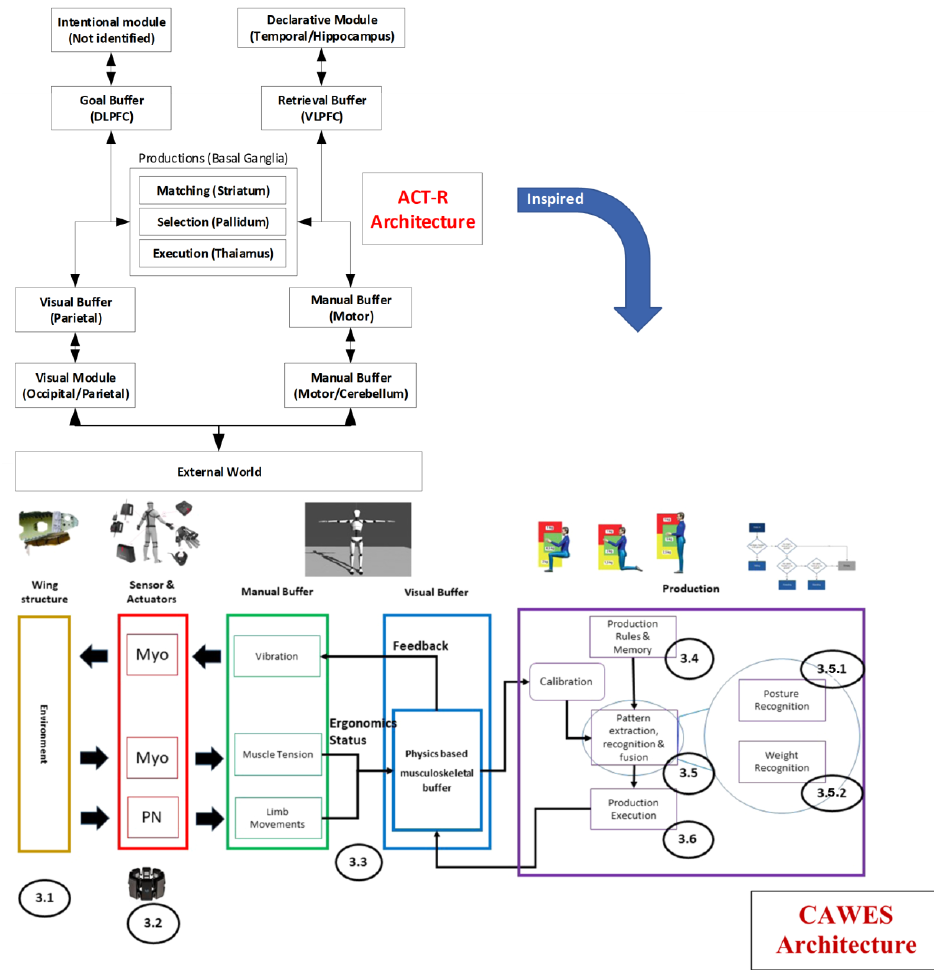
Figure 2. CAWES architecture—A Cognitive Architecture for Wearable Sensors